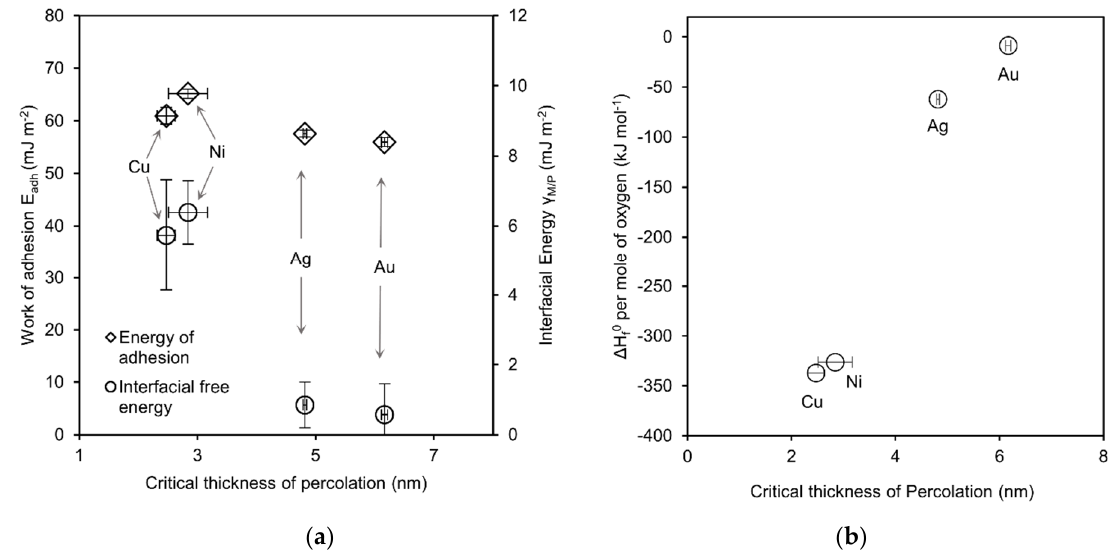
Figure 3. Plots of ( a ) energy of adhesion ( E adh ) and interfacial energy ( γ M/P ) and ( b ) standard heat of metal-oxide formation ( ∆ H f0 ) per mole of oxygen versus critical thickness of percolation for the investigated elements as indicated. Vertical error bars represent standard deviation, horizontal error bars represent sample range of d c